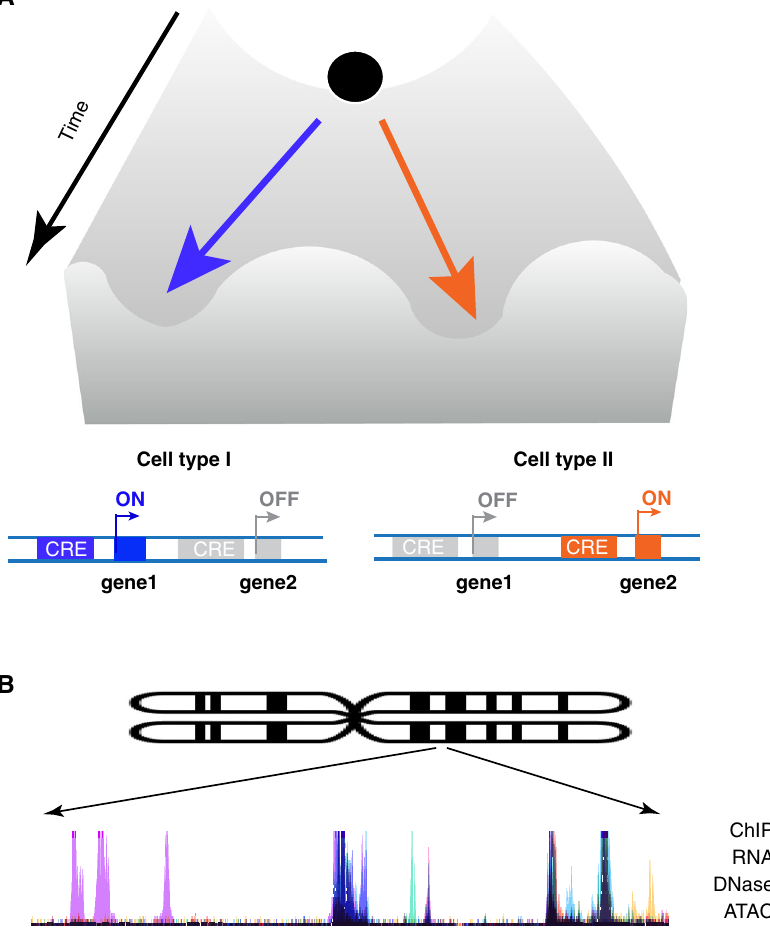
Fig. 1 a Schematic illustration adapted from C.H. Waddington ’ s "epigenetic landscape": as development proceeds, a stem/progenitor falls down a likelihood hill toward terminal differentiation at the bottom. At the molecular level, cell fate speci fi cation and differentiation are controlled by select expression of genes in the genome. b The pattern of biochemical activities on the chromosome can be characterized by next-generation sequencing-based technologies. These patterns provide a comprehensive view of the